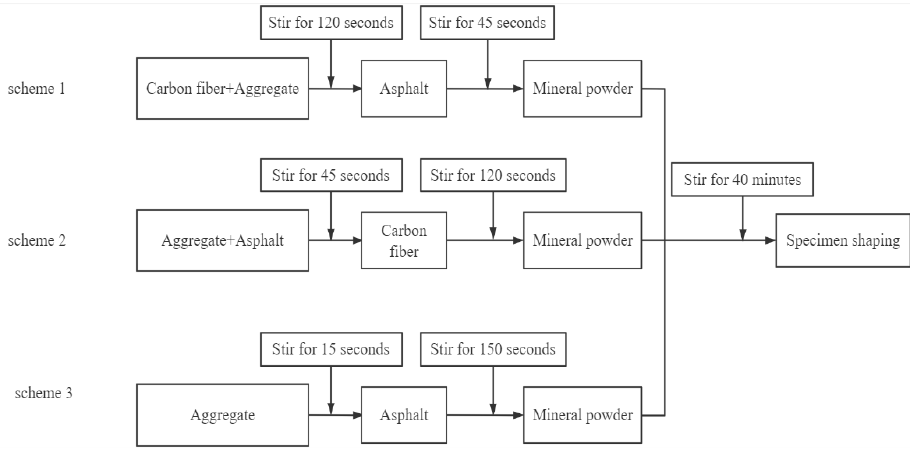
Figure 8. Carbon fiber dispersion scheme.